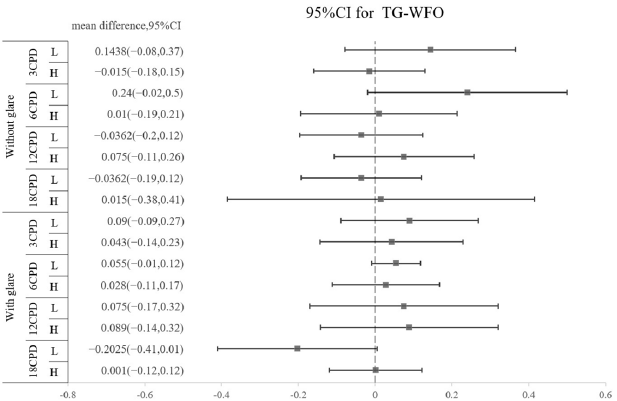
Figure 3. Difference in postoperative contrast sensitivity between TG and WFO stratified by cycles per degree (3, 6, 12, and 18 CPD), glare (off and on) and level of myopia (high and low).